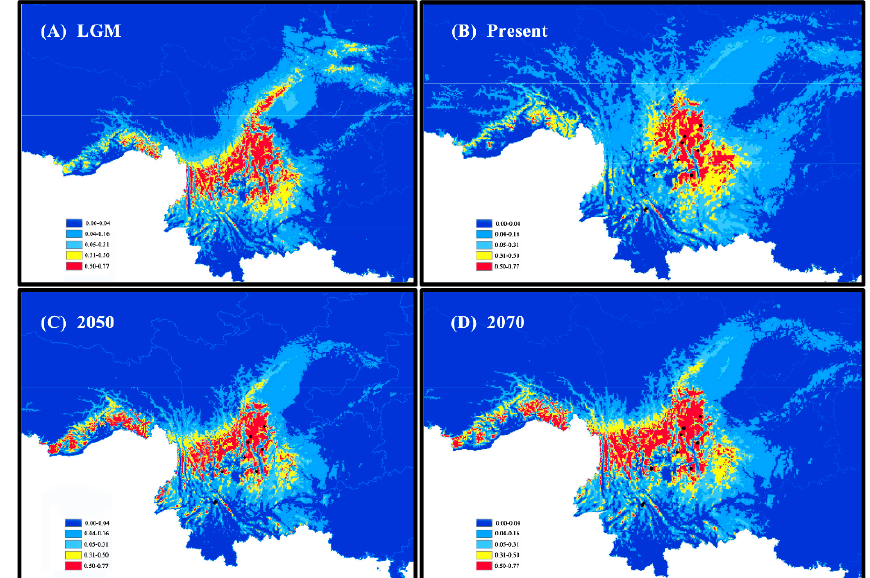
Figure 5. Distribution dynamics of R. rex subsp. rex using MAXENT. Predicted distributions are shown for ( A ) the last glacial maximum (LGM), ( B ) the present, ( C ) the year 2050, and ( D ) the year 2070. Color-coded keys represent different habitat suitability.